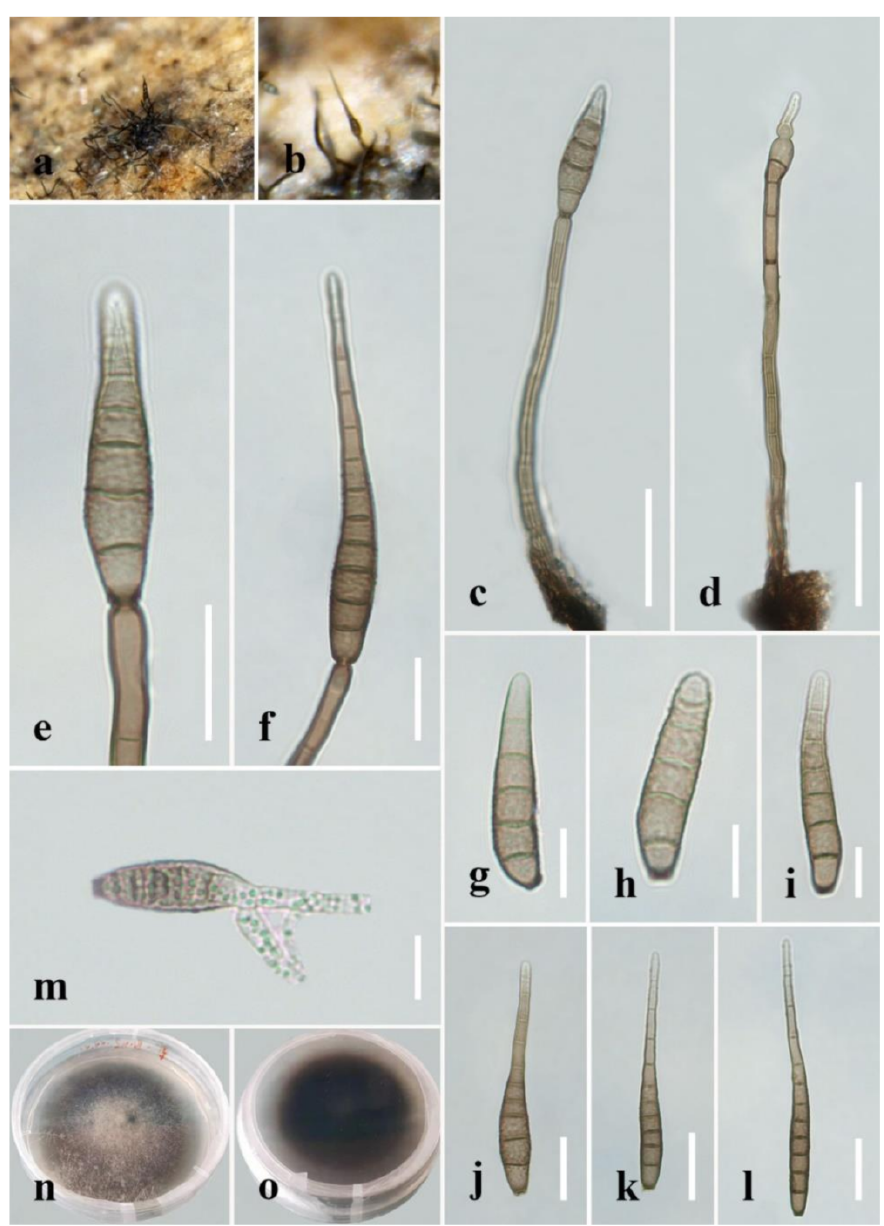
Figure 4. Distoseptispora aquamyces (HKAS 122186, holotype). ( a , b ) Colonies on natural substrate. ( c , d ) Conidiophores with conidia. ( e , f ) Conidiogenous cells bearing conidia. ( g − l ) Conidia. ( m ) Germinated conidium. ( n ) Colony on PDA (from front). ( o ) Colony on PDA (from reverse). Scale bars: ( c , d ) 40 µ m; ( e , f , j – l ) 20 µ m; ( g – i , m ) 10 µ m. Distoseptispora bambusae Y.R. Sun, I.D. Goonasekara, Yong. Wang bis & K.D. Hyde, Biodiversity Data Journal 8(e53678): 6 (2020) (Figure